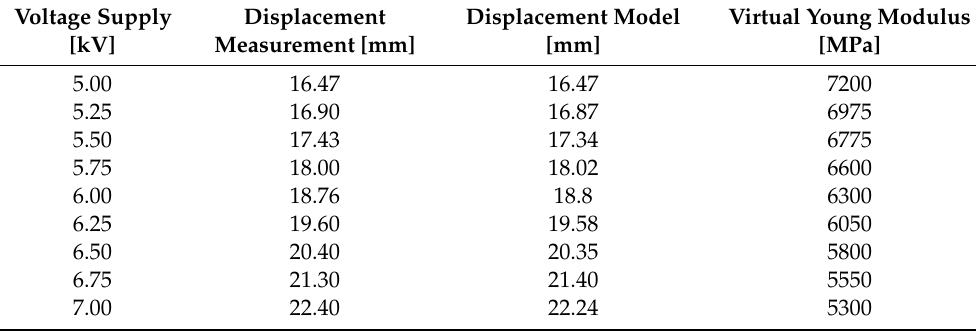
Table 6. The comparison of the displacements for di ff erent voltage supply and load force 1.42 [N]. Voltage